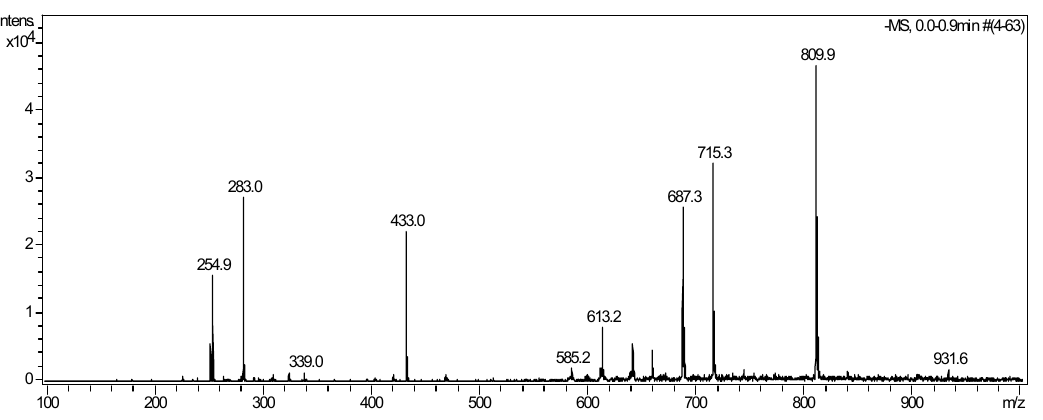
Figure 1. Mass spectrum of the complex [Cr(C 15 H 9 O 4 ) 3 ] in hydroalcoholic solution (90MeOH:10H 2 O).